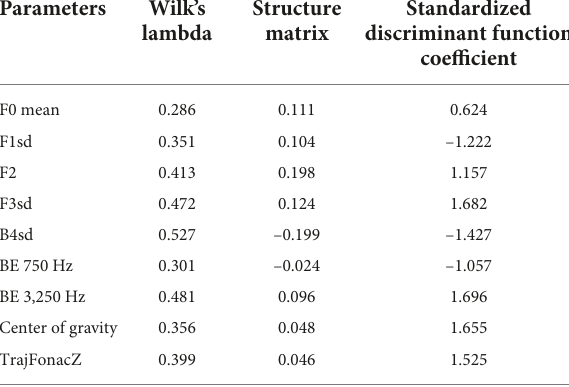
TABLE 3 Characteristics of the discriminant function for high blood